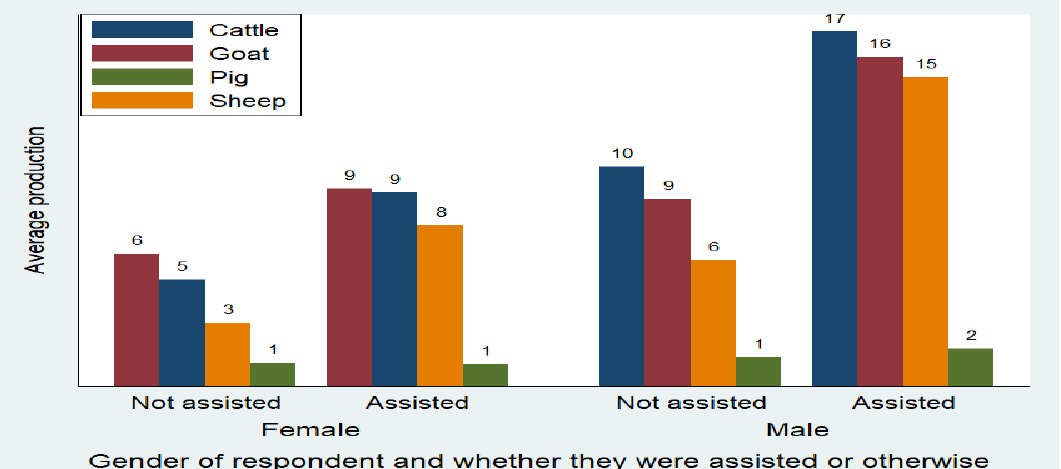
Figure 2. The difference in the production rate between those who received assistance and those who did not receive.